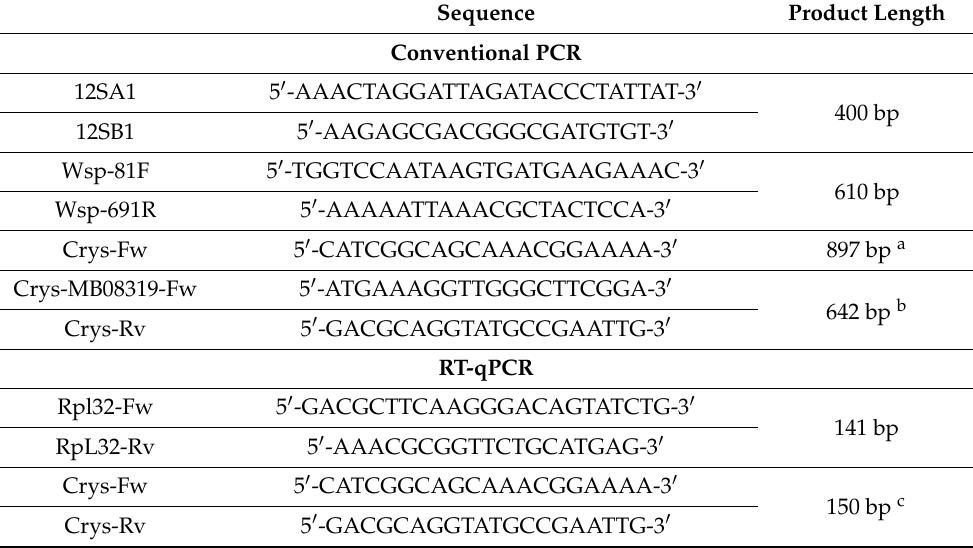
Table 1. Primers used in this